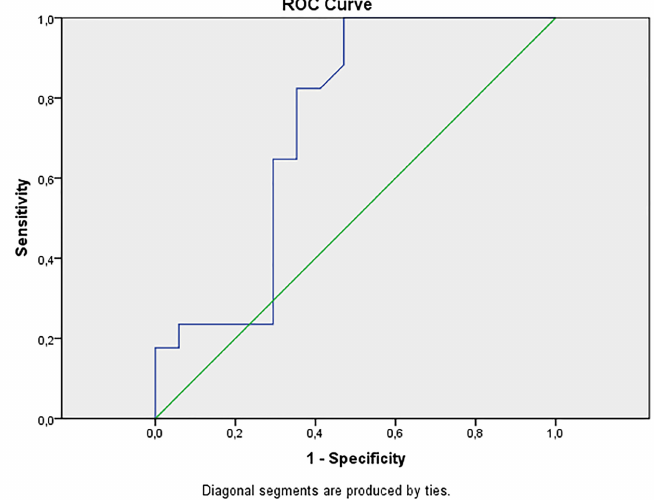
Figure 1 - ROC curve for serum ACE values in the Study and Control